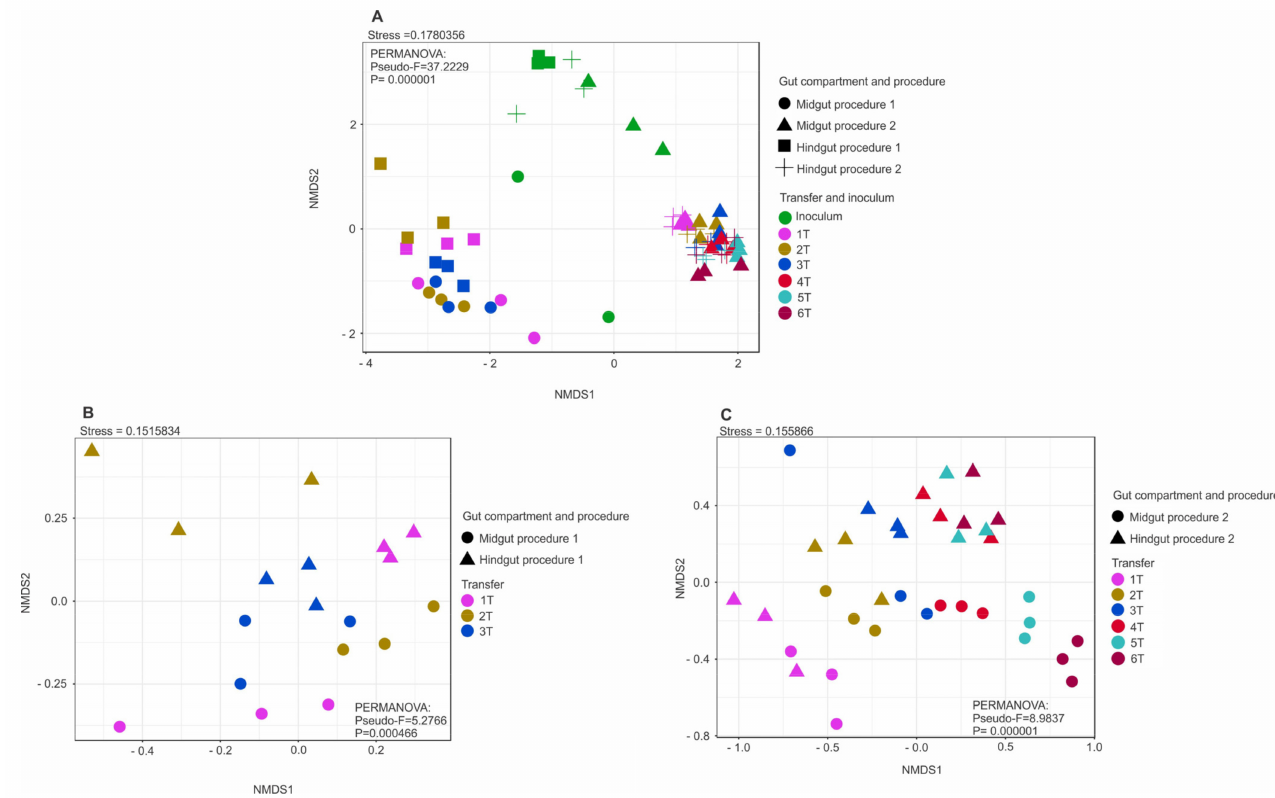
Figure 5. NMDS plots based on mcrA gene amplicon sequences using the Bray-Curtis dissimilarity index and permutational multivariate analysis of variance (PERMANOVA) ( n = 3). Statistics are provided as inset panels. ( A ) Inocula, enrichment cultures of P1 and P2. ( B ) Only samples from enrichment cultures of P1 and ( C )